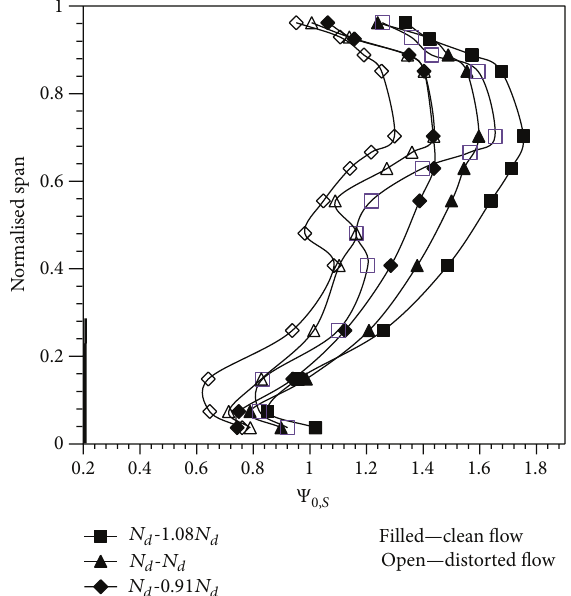
Figure 5: Spanwise variation of total pressure rise coefficient: design mass flow